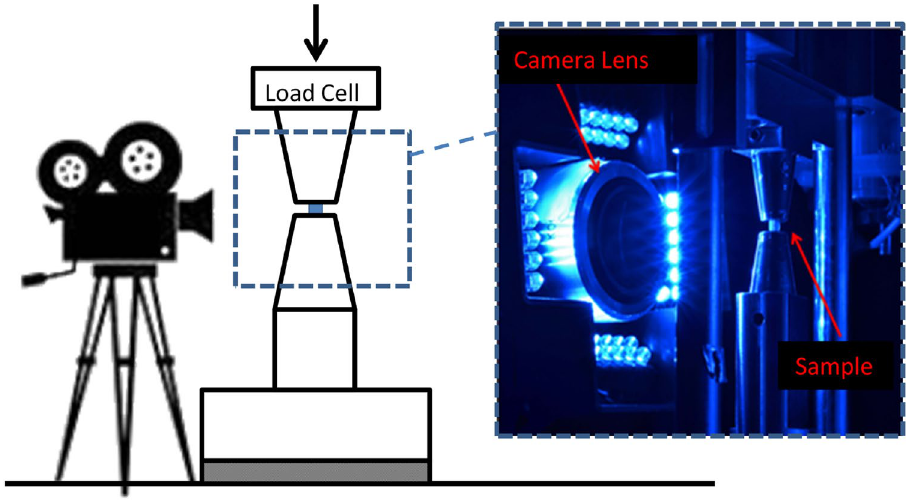
Figure 2. Schematic mechanical compressive test device. High resolution camera records the cubic sample motion under